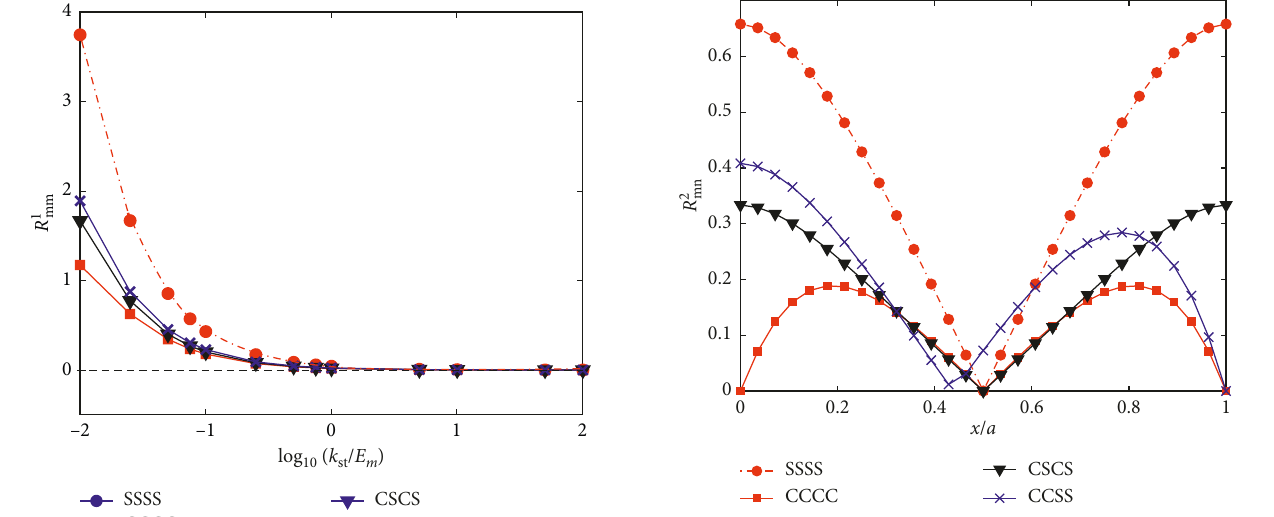
/ E m on R 1 mn of the plate with st